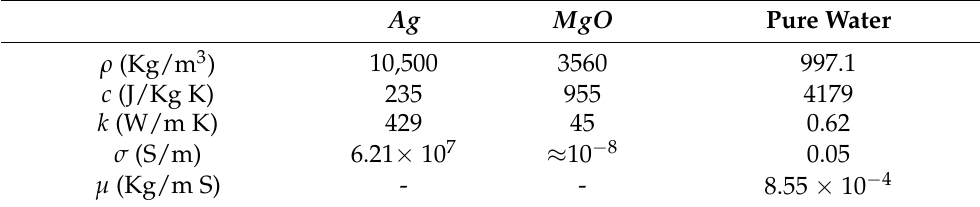
Table 1. Thermophysical properties of basefluid and nanoparticles (Ag and